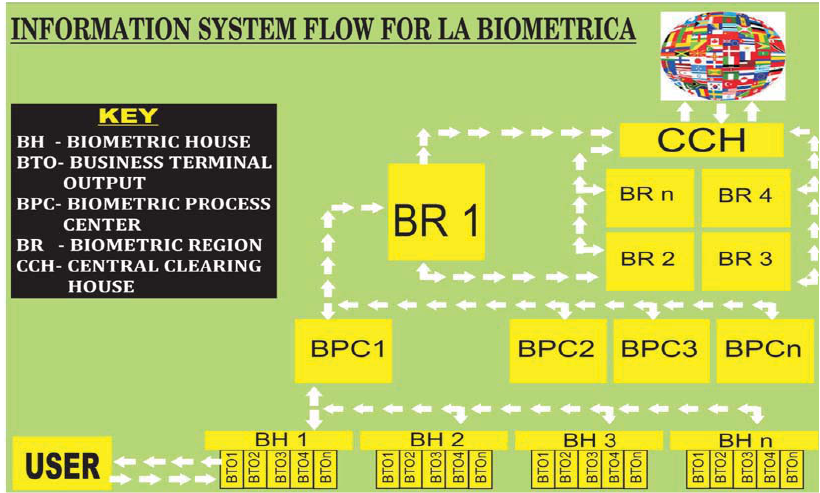
Fig. 2. Drawing derived from a conceptual expectation of information system